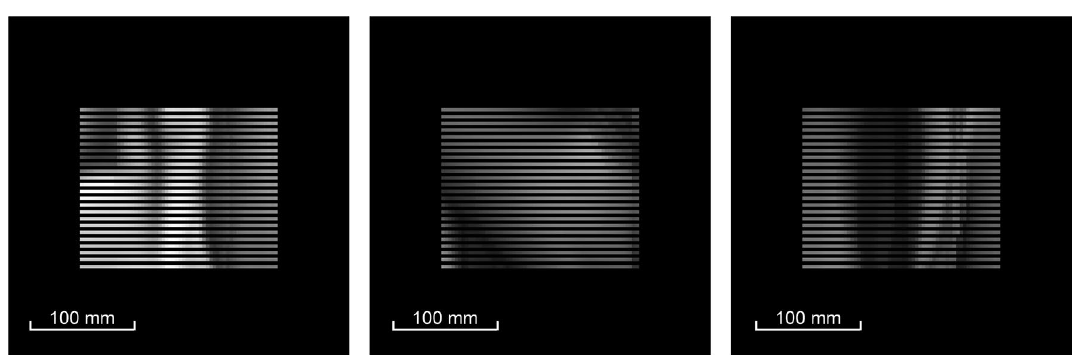
Figure 13. Intensity distribution in the focal plane (f = 300 mm) for three different elementary regions G ij